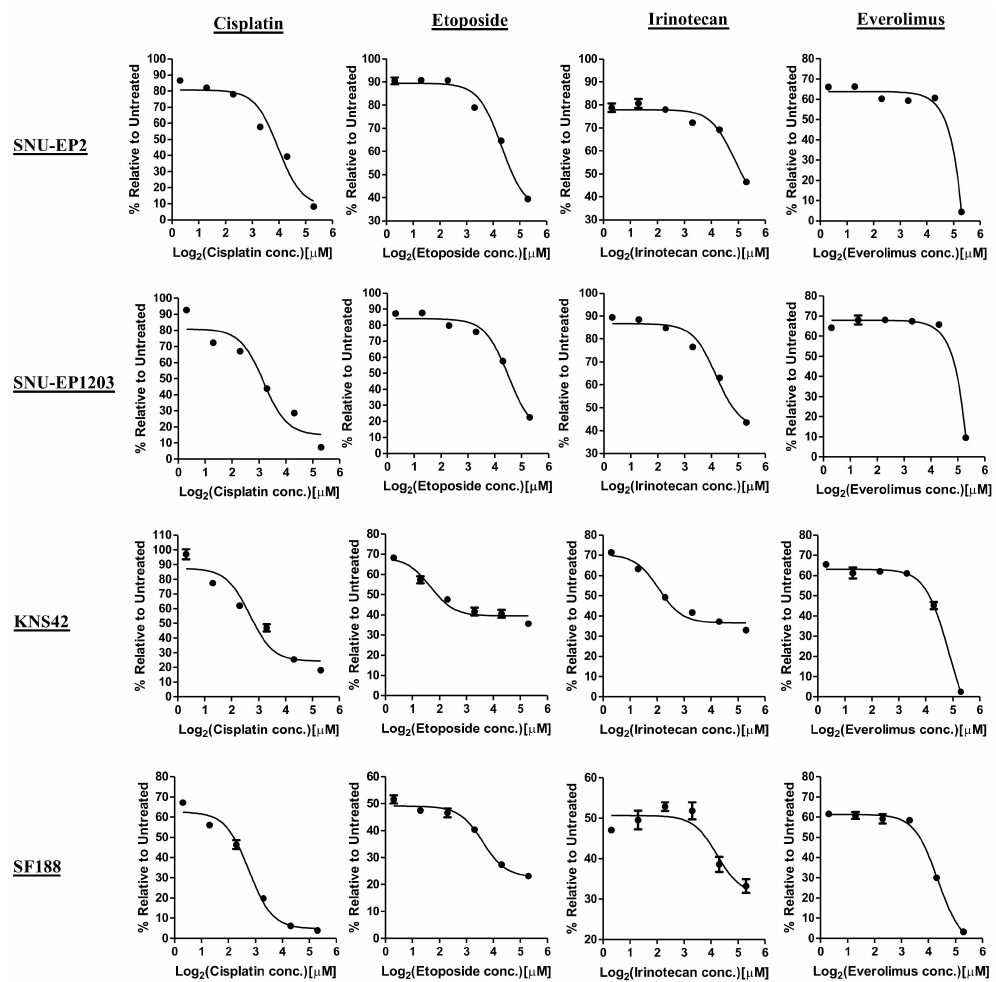
Figure 1. Ependymoma cells are resistant to currently used chemotherapy agents. SNU-EP2, SNU-EP1203, KNS42, and SF188 cells were treated with the indicated concentrations of cisplatin, etoposide, irinotecan, and everolimus. The IC 50 values were determined by using MTT assay. The IC 50 value of cisplatin was 14.18 µ M in SNU-EP2, 8.67 µ M in SNU-EP1203, 8.95 µ M in KNS42, and 4.07 µ M in SF188. The IC 50 value of etoposide was 31.61 µ M in SNU-EP2, 24.38 µ M in SNU-EP1203, 4.39 µ